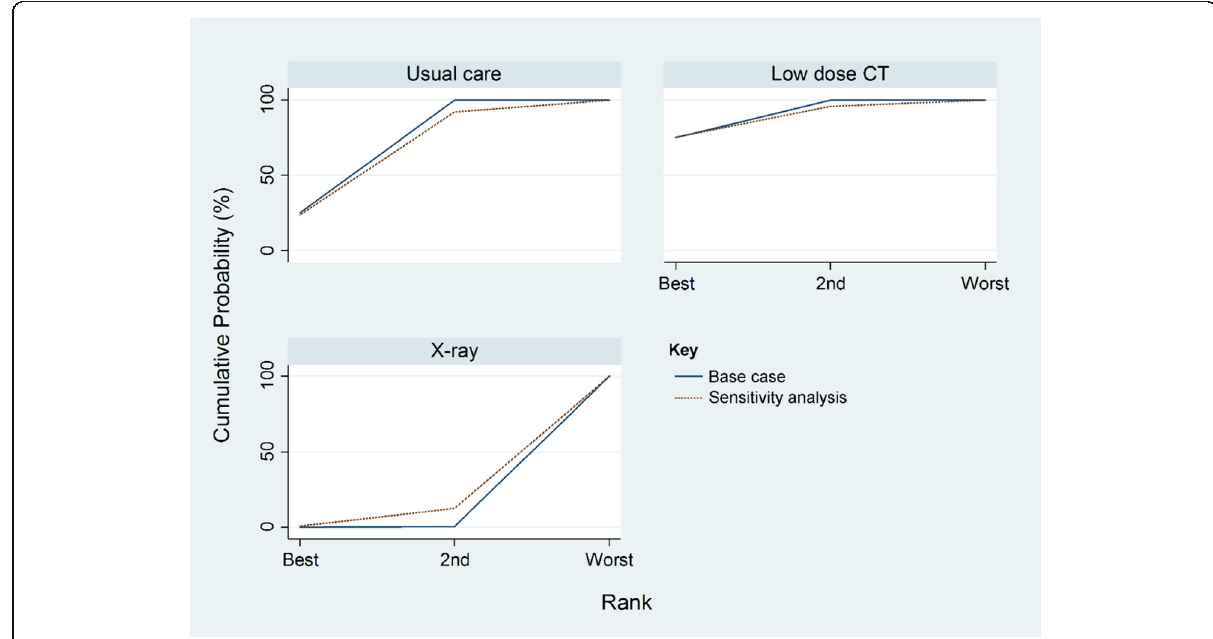
Fig. 4 Network meta-analysis